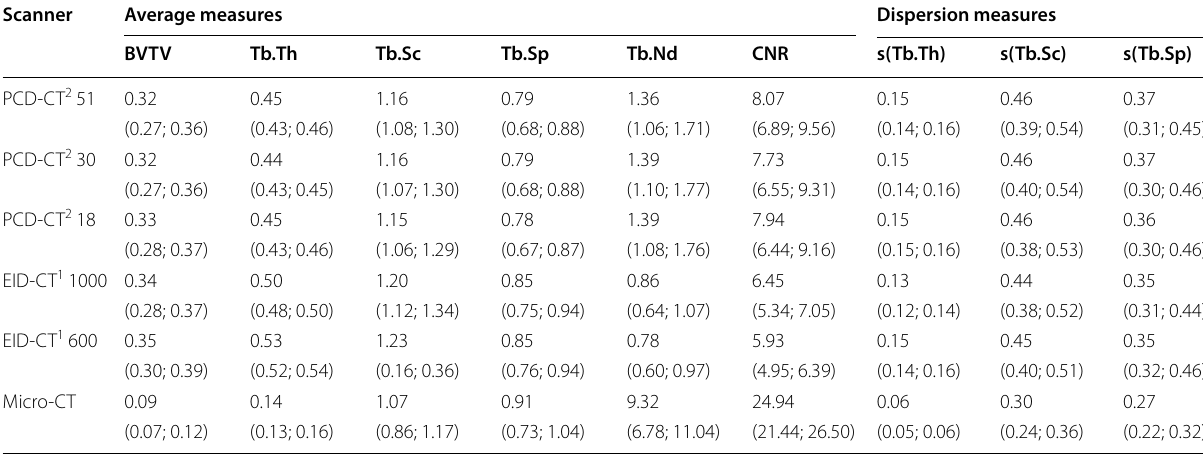
Data are presented as median (1st quartile, 3rd quartile) BVTV Bone volume fraction, CNR Contrast-to-noise ratio, EID-CT Multislice computed tomography using energy-integrating detectors, Micro-CT Micro-computed tomography, PCD-CT Multislice computed tomography using photon-counting detectors, Tb.Nd Trabecular nodes, Tb.Th Trabecular thickness, Tb.Sc Trabecular spacing, Tb.Sp Trabecular separation. s(Tb.Th), s(Tb.Sc) and s(Tb.Sp) are the intra-volume standard deviation for Tb.Th, Tb.Sc and Tb.Sp, respectively. The numbers after the type of scanner correspond to the field of view in mm (PCD-CT) and quality reference tube load in mAs